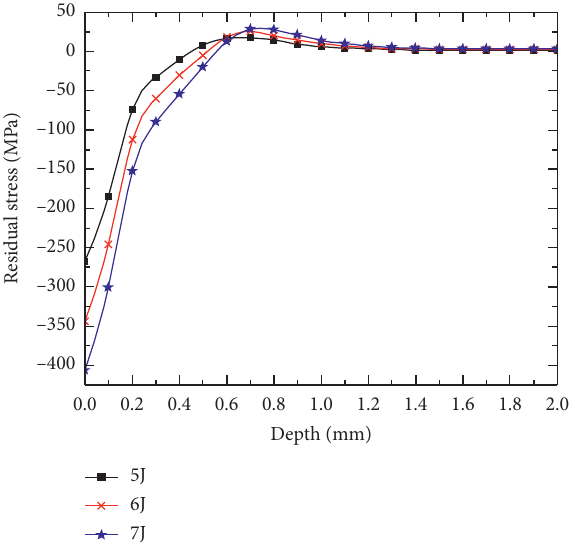
Figure 9: Curves of residual stress distribution in-depth direction of sample surface with different laser